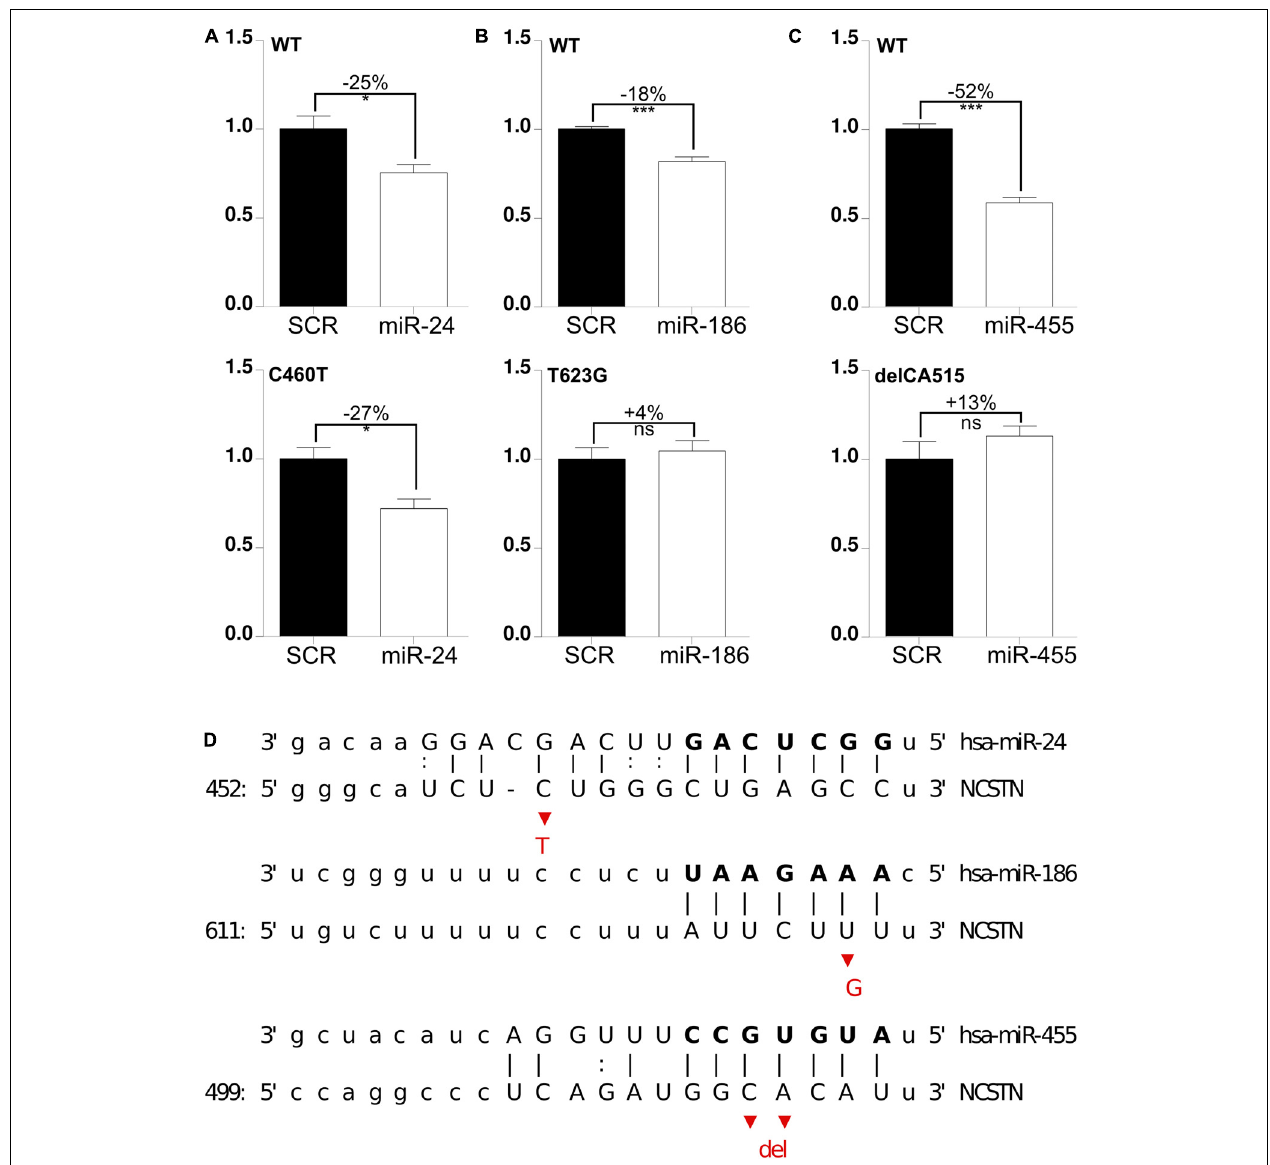
results ( n = 3, performed in triplicate) are shown. Statistical significance was assessed by Student’s paired t -test (* p < 0.05, *** p < 0.001, ns, not significant). SCR; scrambled. (D) Schematic representation of base pair matching between miRNAs and the 3 (cid:2) UTR of hNCSTN . The seed region of the miRNAs is indicated. The red bases represent the SNPs C460T (upper panel), T623G (middle panel), and delCA 515–516 (lower